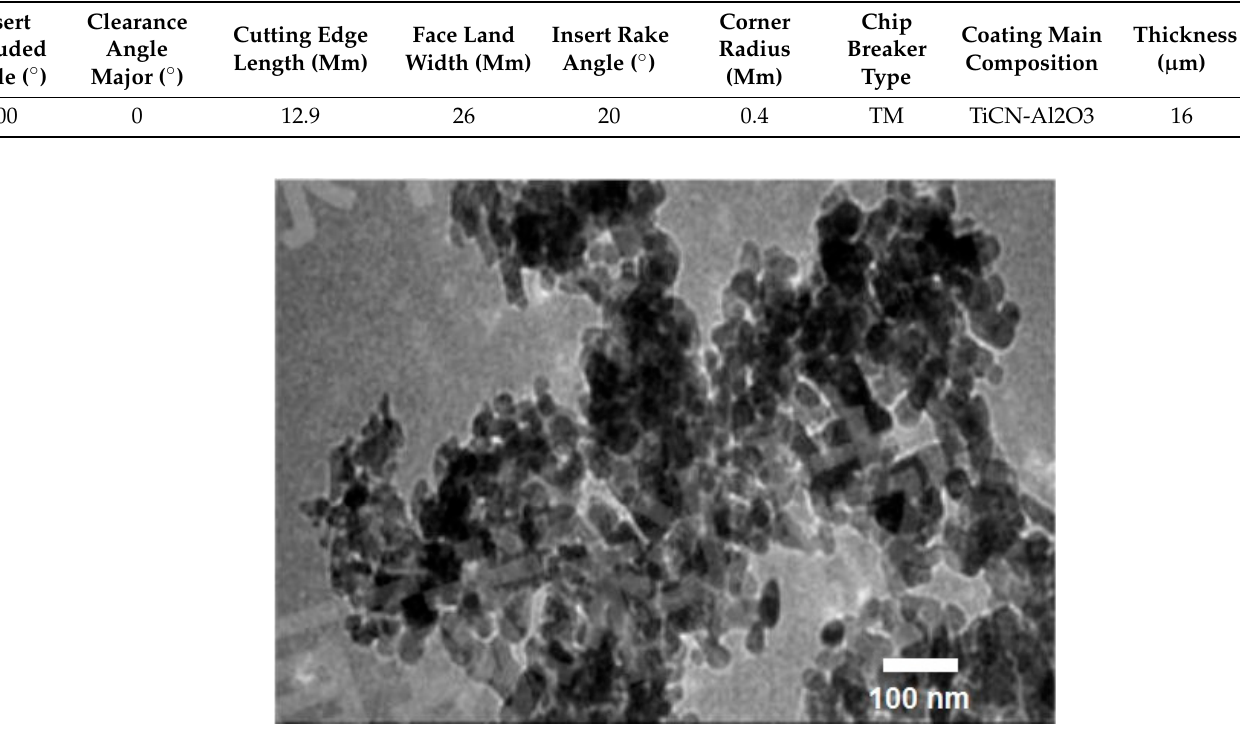
Figure 3. TEM image of MoS 2 nanosheets. Adapted from [32]. Table 1. Chemical composition in % of 90CrSi steel (DIN 17350-80 ) . The 2 k-p experimental design with 6 input variables was used to evaluate the influence of fluid type (FT), lubrication method (LM), nanoparticle type (NP), nanoparticle concen- tration (NC), cutting speed (V) and feed rate (f) on surface roughness R a (Table 4) and their value levels were based on the previous study Table 2. Mechanical properties under Т = 20 ° С of 90 CrSi steel.